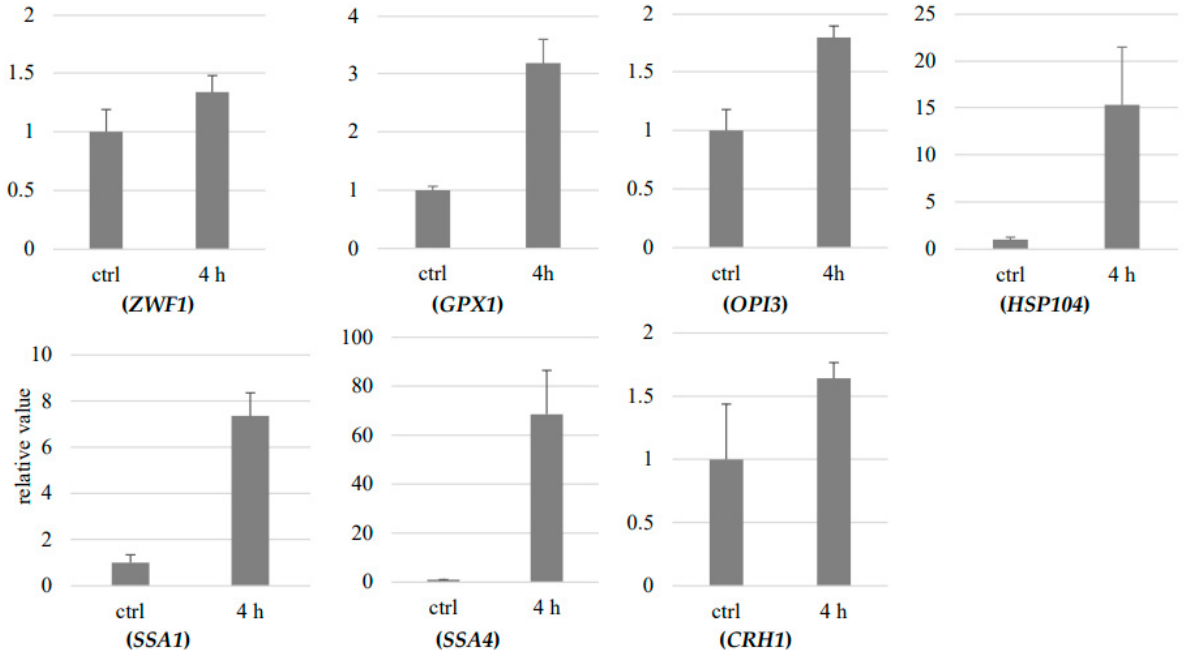
Figure 2. RT-qPCR validation. X axial shows the samples which are treated by HPCD 4.0 MPa 30 °C 4 h. Y axial shows relative value. The word ‘ctrl’ means ‘control sample’.